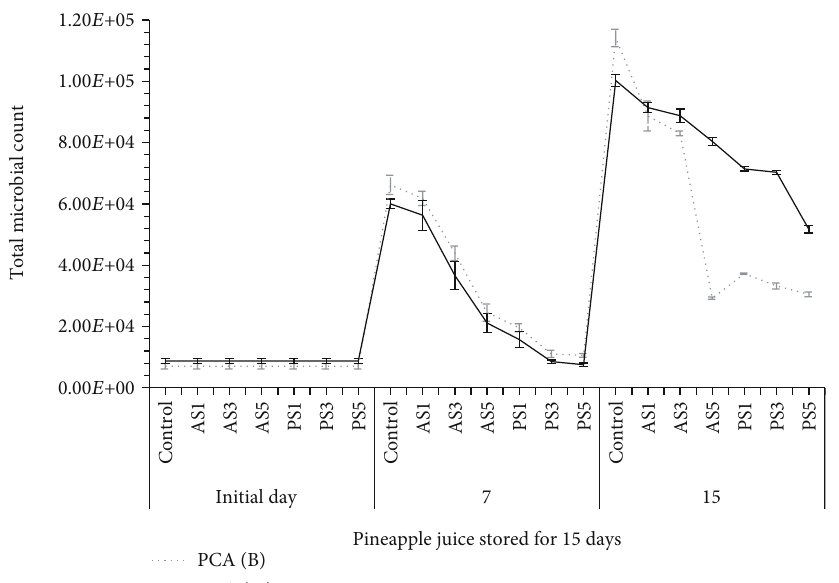
Figure 2: Microbial load of pineapple juice stored for 15 days. Control: pineapple juice (without starch); AS1: 1% anchote starch; AS3: 3% anchote starch; AS5: 5% anchote starch; PS1: 1% potato starch; PS3: 3% potato starch; PS5: 5% potato starch; PCA (B): total bacterial count; PDA (M): total fungi